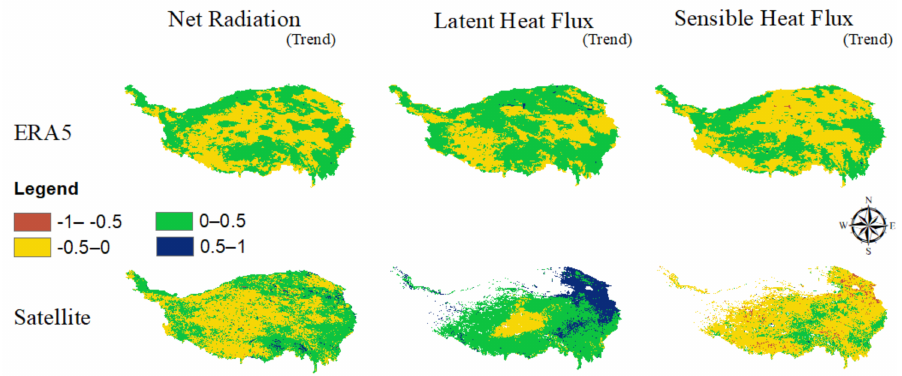
Figure 3. Spatio-temporal trends of (R N ), latent heat flux (LE), and sensible heat flux (SH) from ERA5 and satellite data using M-K τ value. Negative values (red and yellow) correspond to the decreasing trend while positive values (green and blue) correspond to the increasing trend; white regions in satellite LE and SH are the missing